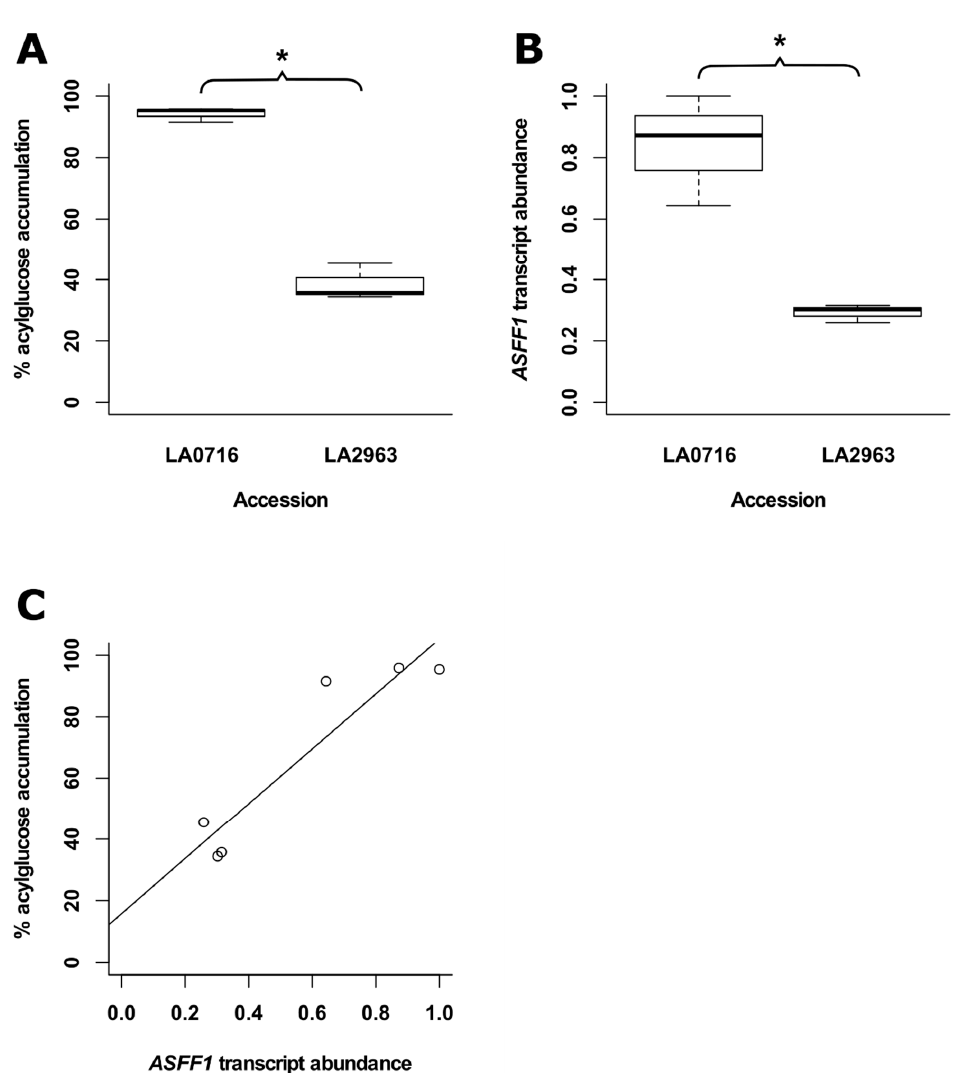
Figure 8. Analysis of acylglucose accumulation and ASFF1 transcript abundance in paired leaflets of S. pennellii accessions LA0716 and LA2963. ( A ) Percentage of total acylsugars accumulating as acylglucoses. ( B ) Relative abundance of ASFF1 transcripts. ( C ) Linear regression of ASFF1 transcript abundance and percentage of percentage of acylsugars accumulating as acylglucoses (data points represented as open circles; R 2 = 0.84). “*” indicates p < 0.05 (analysis of variance); n = 3 for both accessions.